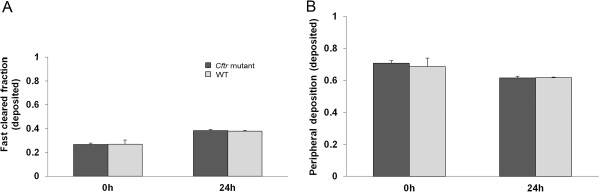
Regional deposition of inhaled IrNP determined either immediately (0 h) or 24 h after a 1-h inhalation exposure. The fast cleared fraction (A) estimates the airway deposition fraction including head airways. Regional deposition is given relative to the totally deposited aerosol. The difference between 0 h and 24 h relates to the fact that fast clearance is not finished after the 1-h inhalation. Therefore, only the 24-h values are to be considered. No significant difference between the two animal groups. Peripheral lung retention (B) represents long-term retained IrNP. The difference between 0 h and 24 h relates to the fact that fast clearance is not finished after the 1-h inhalation, adding to lung retention. Therefore, only the 24-h values are to be considered for IrNP retention in the peripheral lungs. No significant difference between the two animal groups.